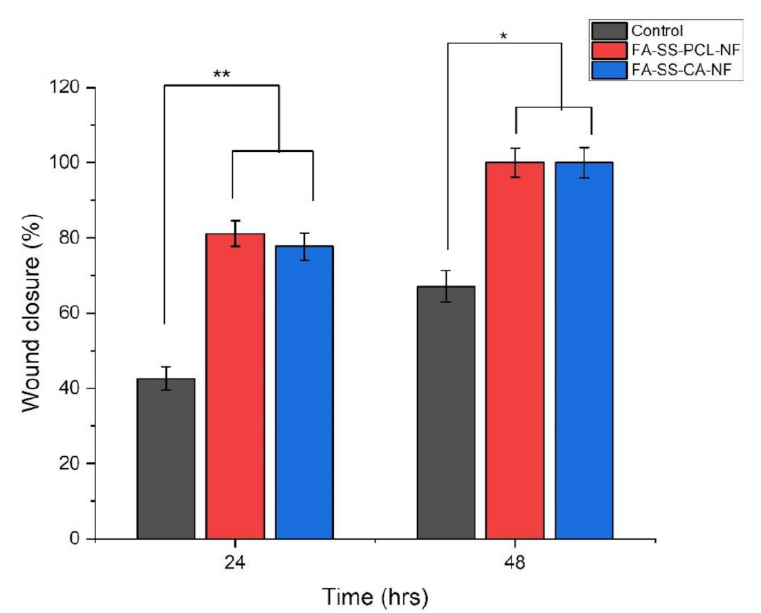
Figure 12. Graphical representation of % wound closure of in vitro wound assay at 24 and 48 h (mean ± S.D). * and ** represent the significant differences between the control and the formulations. Table 4. Effect of diabetes on the average body weight of diabetes-induced rats before and after the treatment with formulations (FA-SS-PCL-NF and FA-SS-CA-NF) at a different time intervals (days